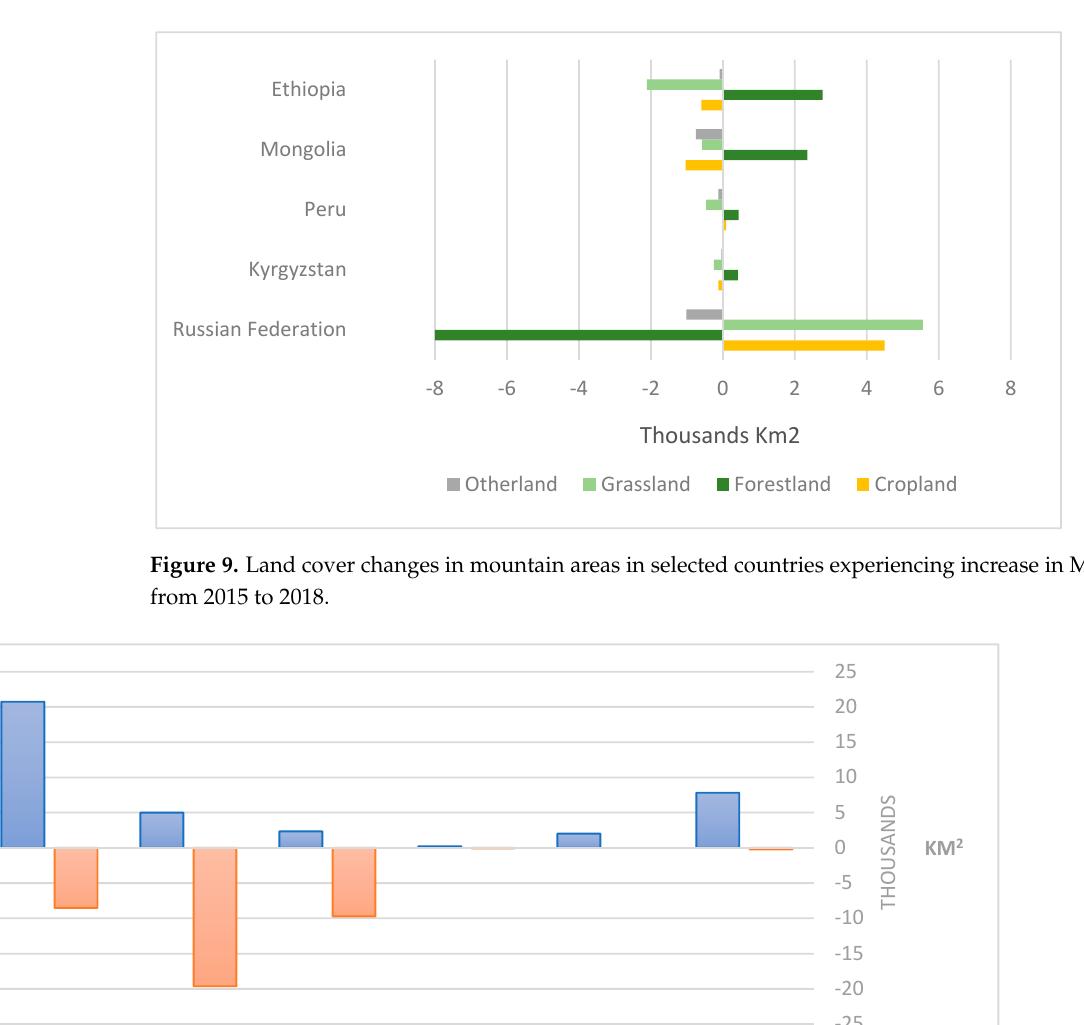
Figure 9. Land cover changes in mountain areas in selected countries experiencing increase in MGCI from 2015 to 2018.